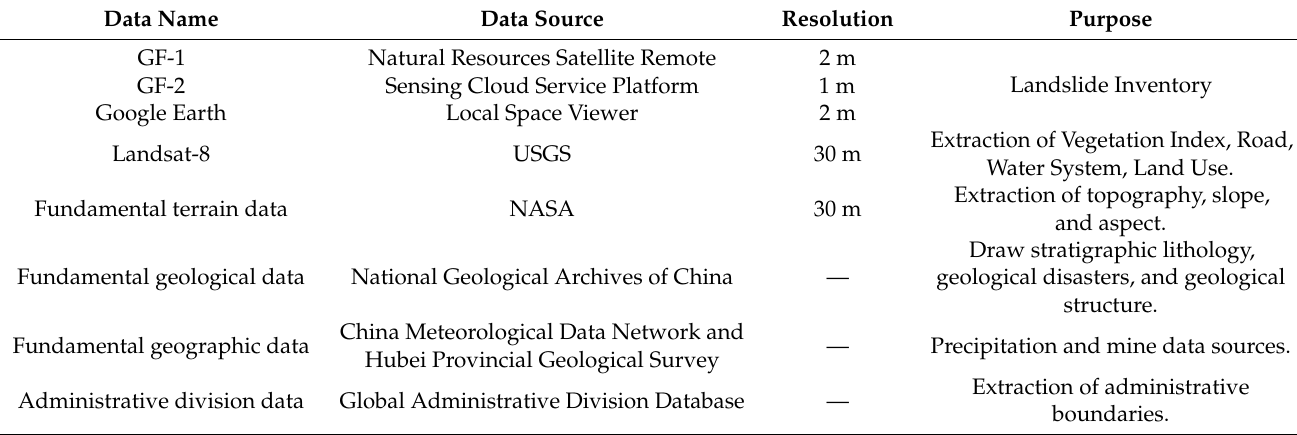
Table 1. Details of the dataset used for